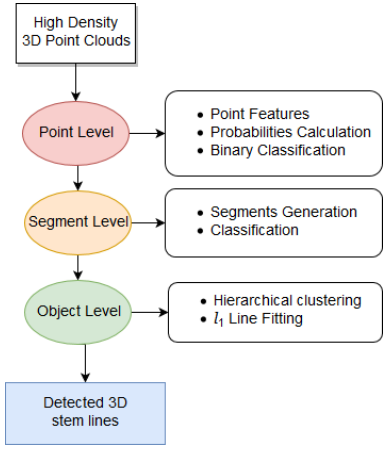
Figure 1. Overview of stem detection